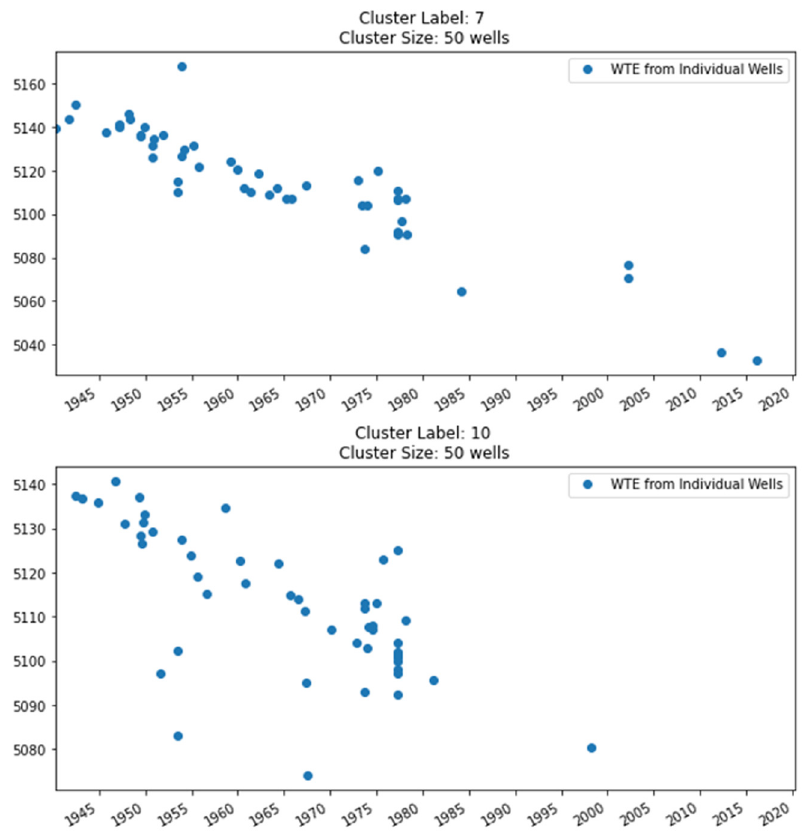
Figure 8. The synthetic WTE time series at two pseudo-wells with irregular time interval and